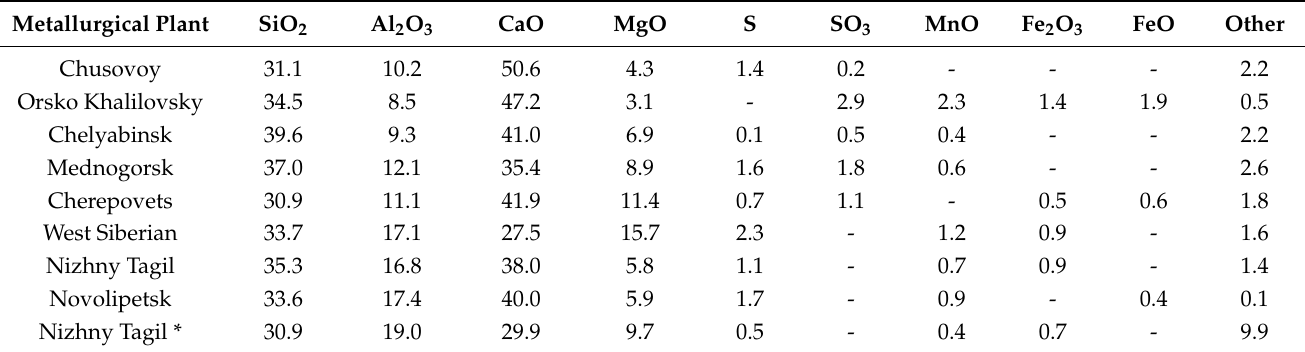
Table 3. Chemical composition (in %) of metallurgical slags.